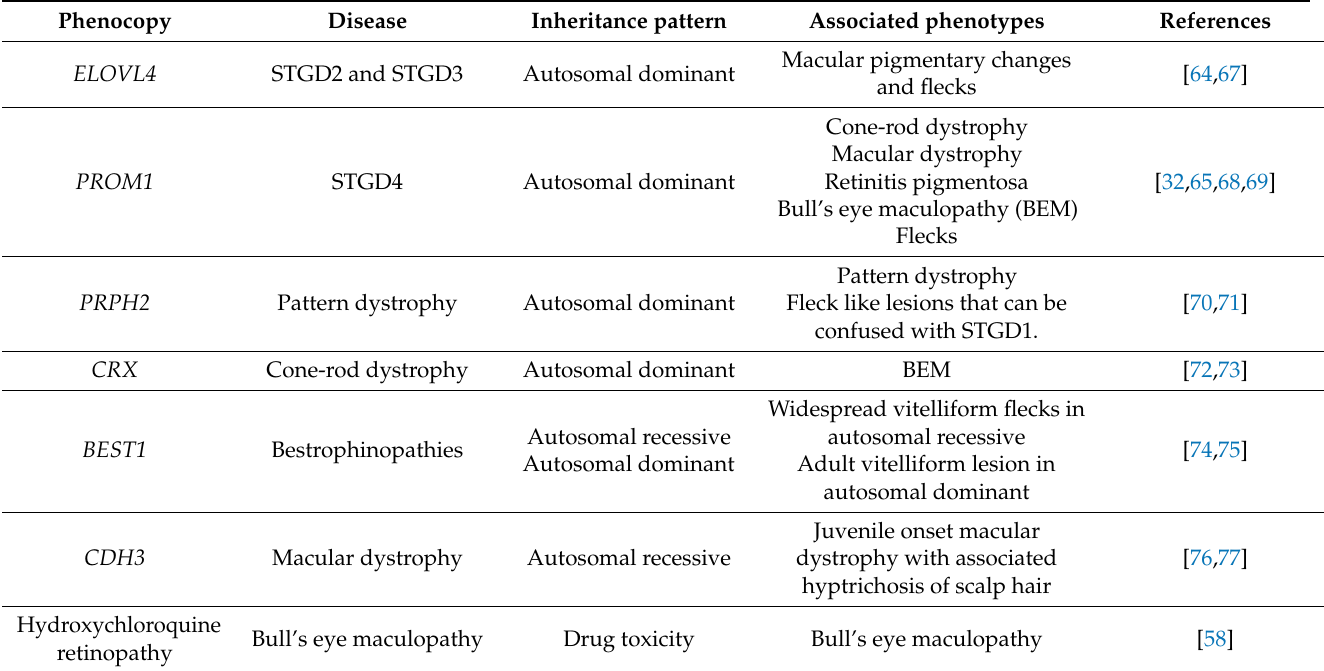
Table 1. A summary of the ABCA4